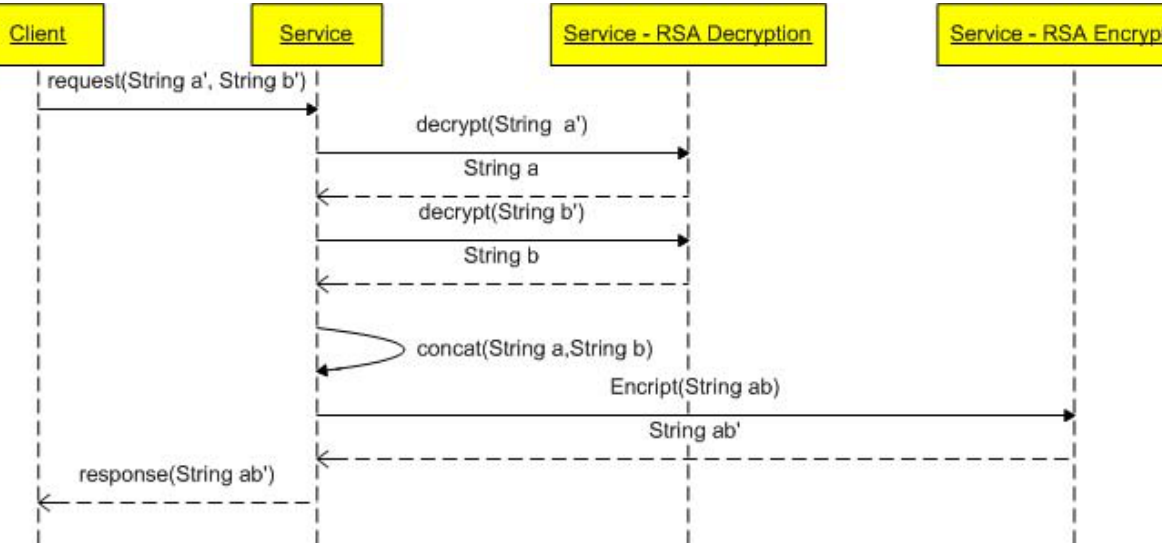
Figure 1. String concatenation service sequence